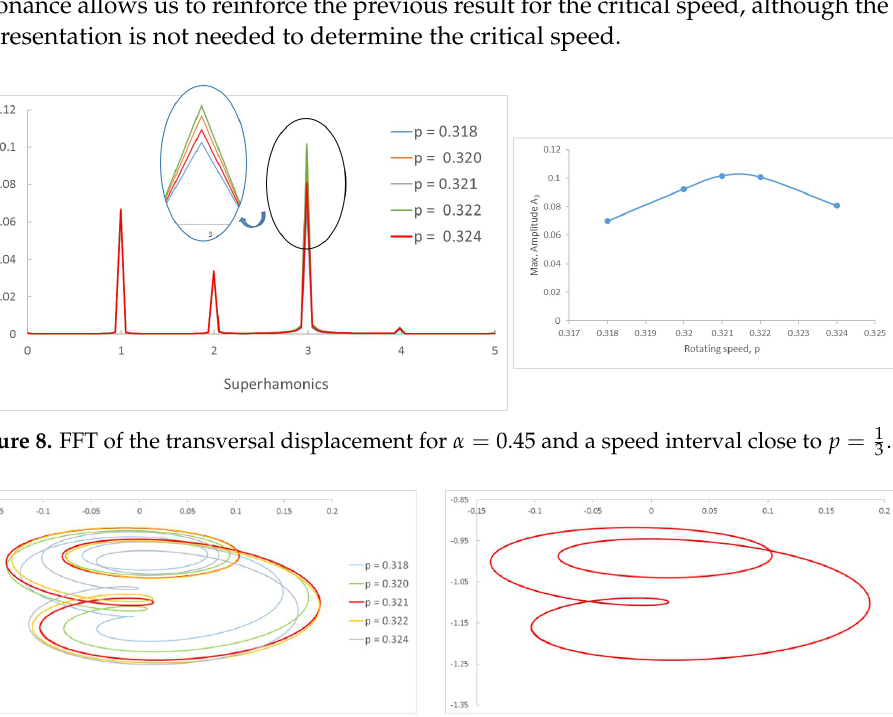
and orbit in p = 3